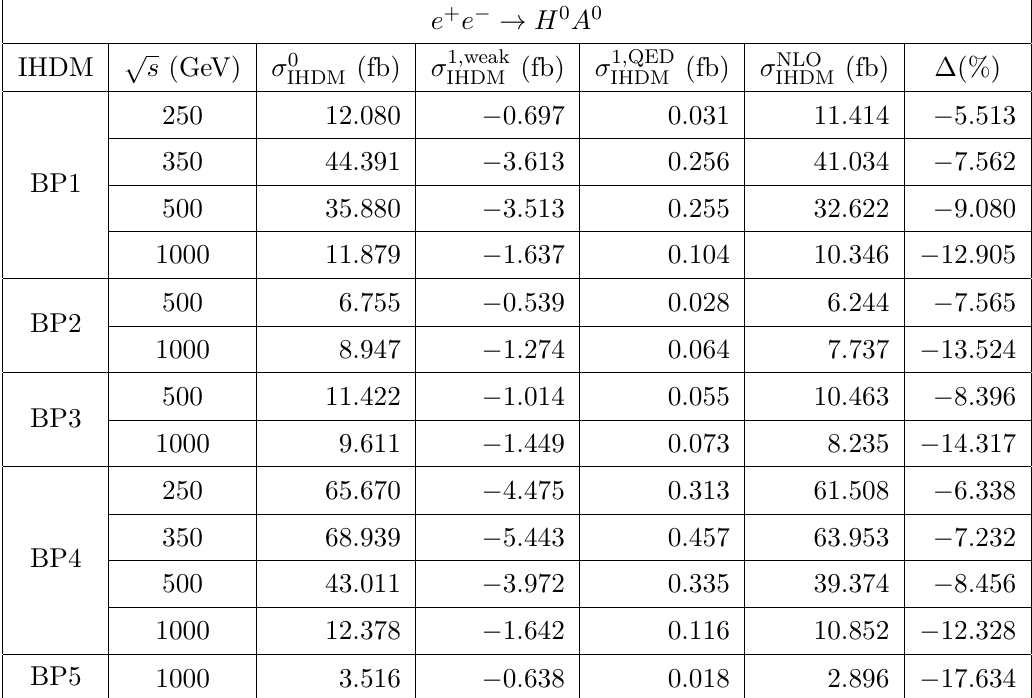
Table 6 . Total cross section for e + e − → H 0 A 0 for different CM